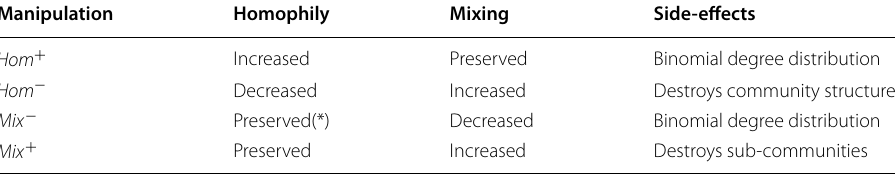
(*) Mix − should result in a “homophilic” graph if the original was “homophilic”, and vice